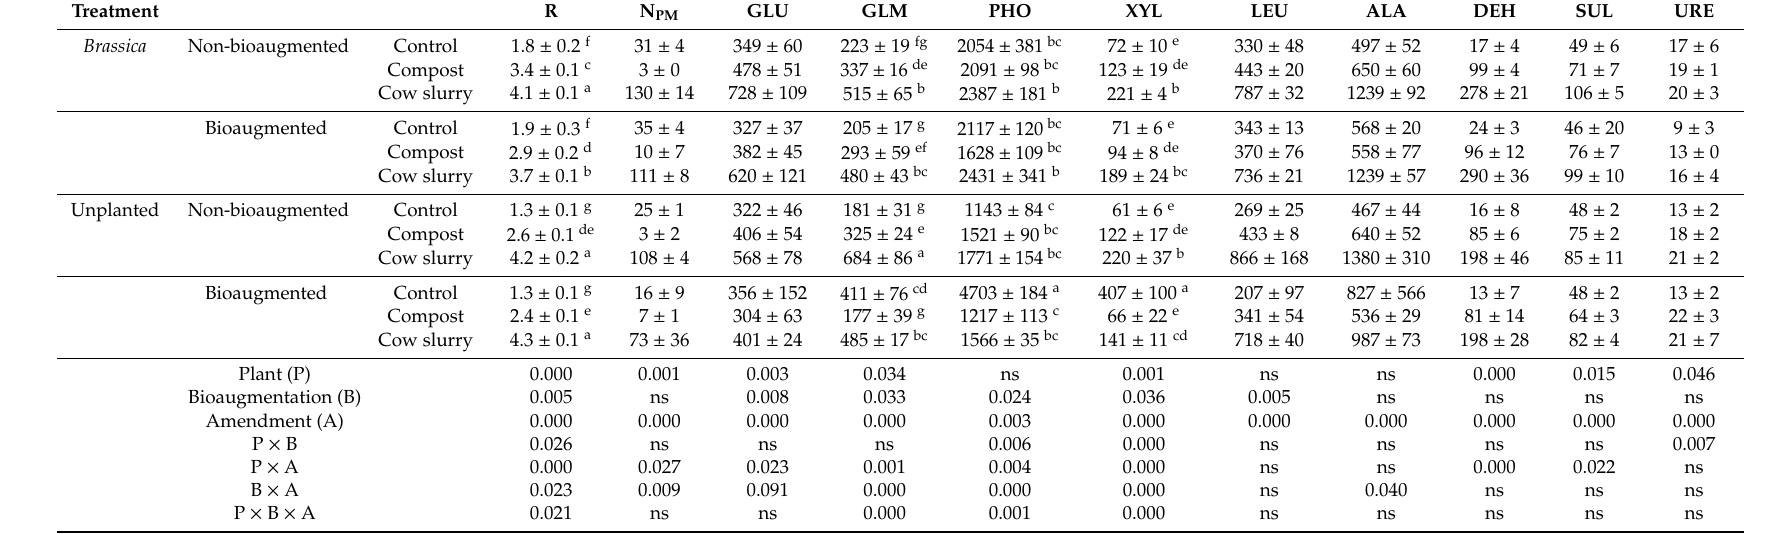
Table 4. E ff ect of treatments on soil microbial activity. Mean values (n = 3) ± SD. Probability values from three-way ANOVA (ns: non-significant) for the e ff ects of plant growth, bioaugmentation, amendment and their interactions are shown below. When the triple interaction is significant, the means with di ff erent letters are significantly ( p < 0.05) di ff erent according to Duncan’s test. R: respiration (mg C kg − 1 DW soil h − 1 ); N PM : potentially mineralizable N (mg N-NH 4 + kg − 1 DW soil); GLU: β -D-glucosidase; GLM: glucosaminidase; PHO: acid phosphatase; XYL: xylosidase ( µ mol MUF kg − 1 DW h − 1 ); LEU: L-Leu aminopeptidase;